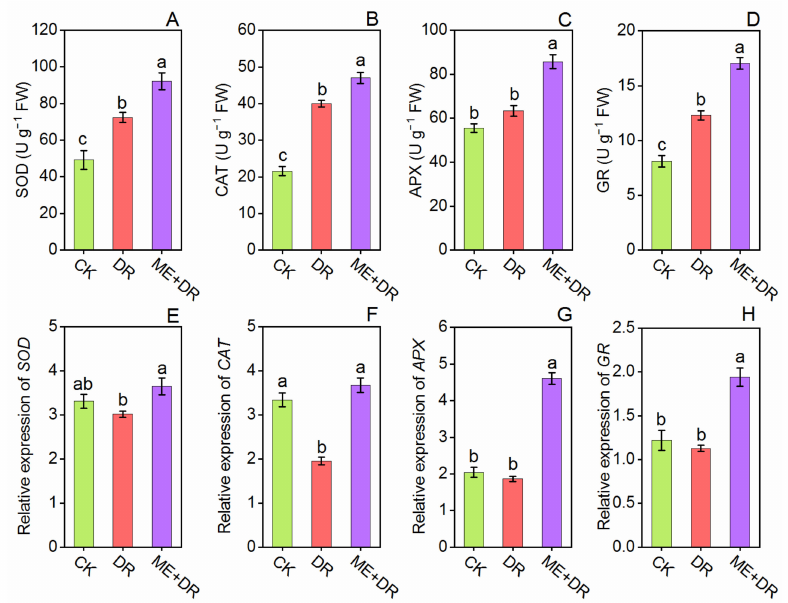
Figure 7. Exogenous supplementation of melatonin promoted antioxidant enzymes [SOD ( A ), CAT ( B ), APX ( C ), GR ( D )] and their encoding genes [ SOD ( E ), CAT ( F ), APX ( G ), GR ( H )] of tomato seedlings under drought stress condition, as shown by leaf’ analysis. Means ± standard error, n = 3, significant difference is exhibited by lowercase letters ( p ≤ 0.05), according to LSD test.